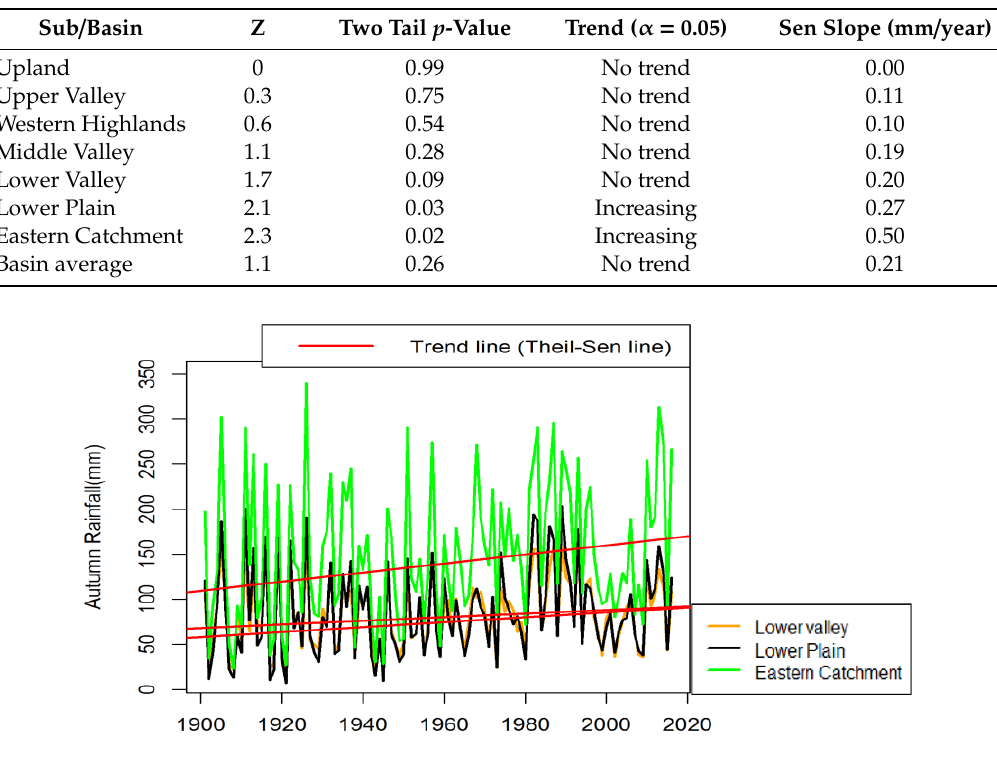
Figure 12. Autumn rainfall time series showing significant increasing trends for the period 1900 – 2016.